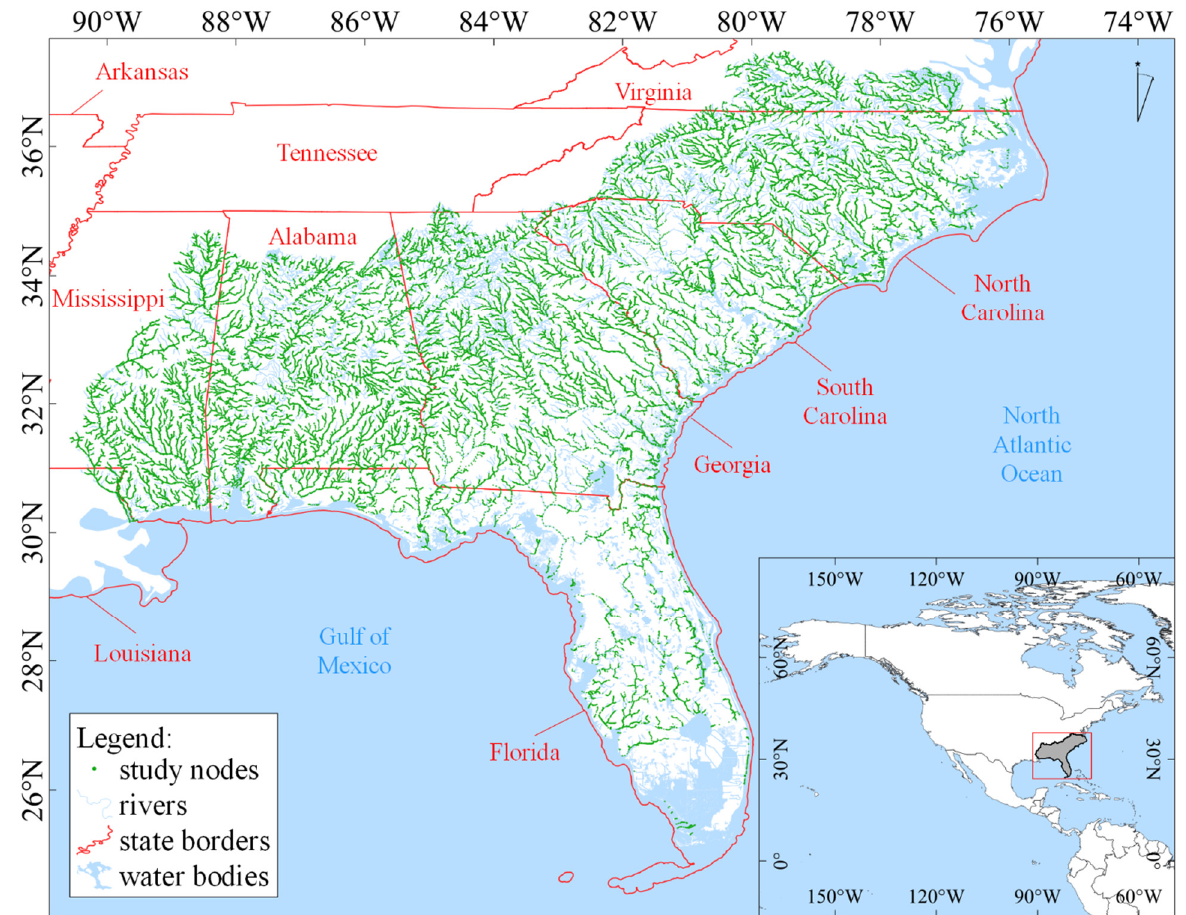
Figure 1. Study area showing NWM nodes used for analysis.